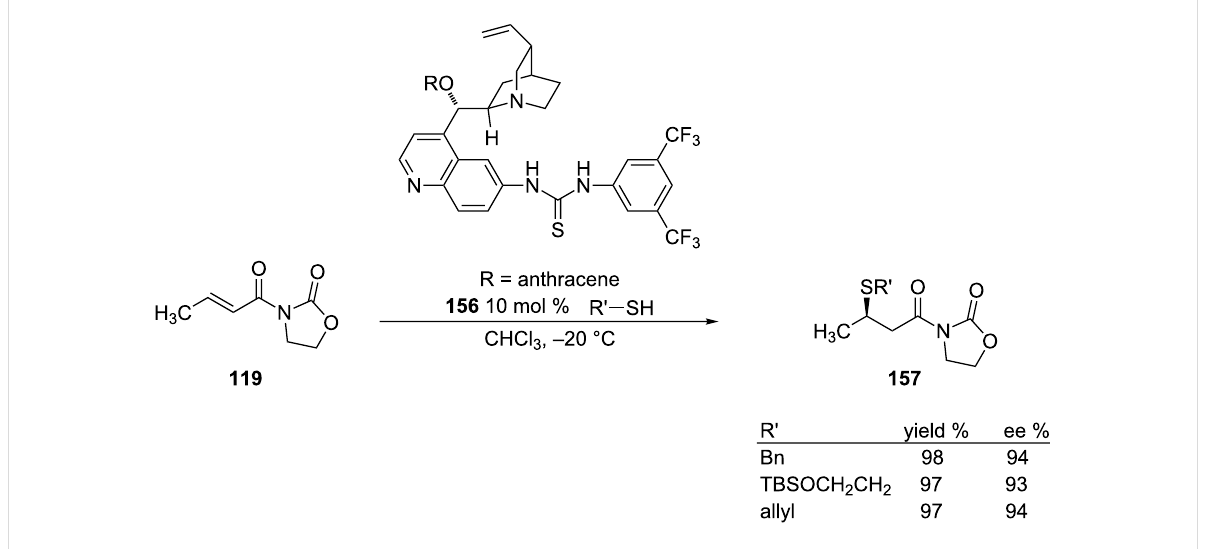
tion of α , β -unsaturated Weinreb amides. Overall, these